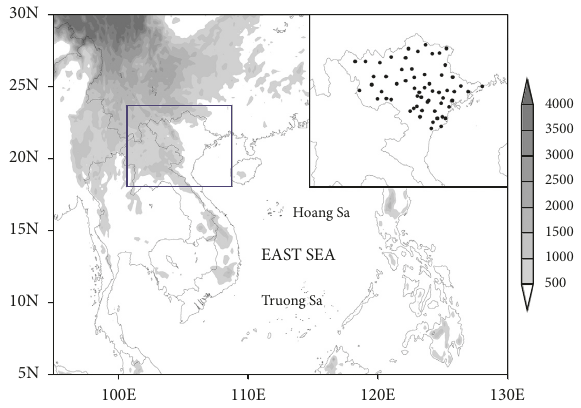
Figure 1: Geographical location of the study region, topography height ( shaded; m ), and selected meteorological observation sta- tions ( closed circles